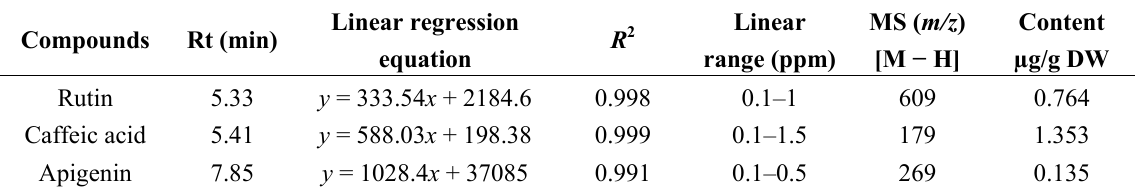
Table 2. Liquid chromatography-mass spectrometry (LC-MS) parameters and amount of selected antioxidant compounds in A. annua